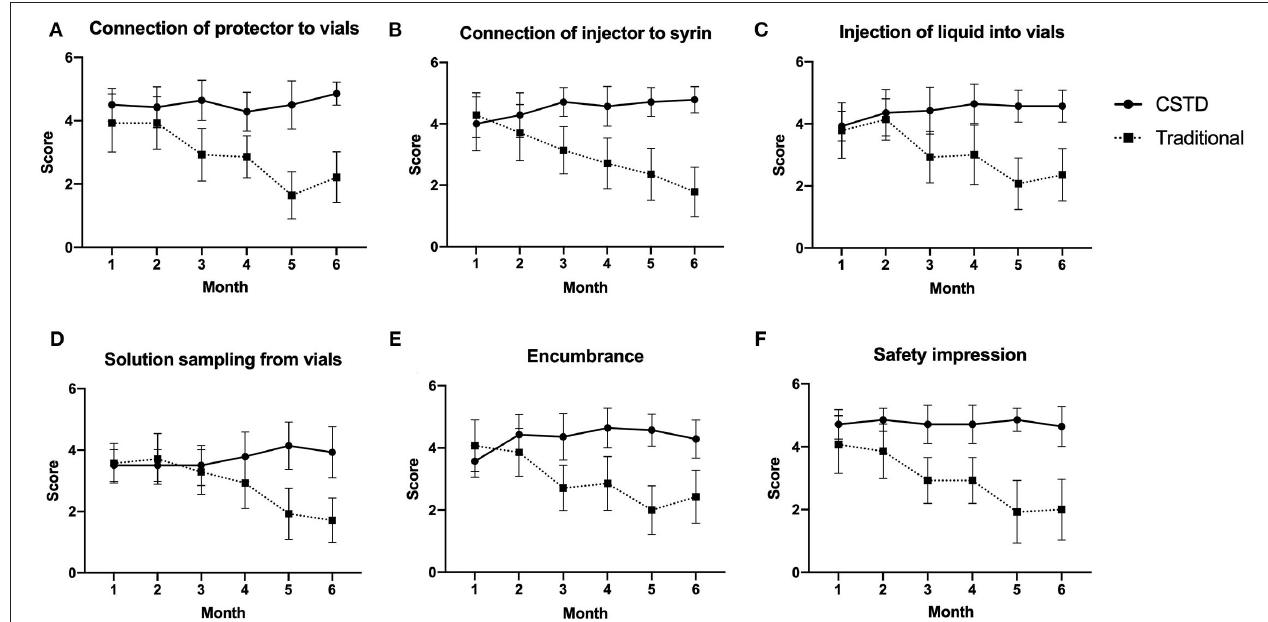
FIGURE 5 | The satisfaction comparison of ergonomics, encumbrance, and safety impression. (A) Connection of protector to vials, (B) connection of injector to syrin, (C) injection of liquid into vials, (D) solution sampling from vials, (E) encumbrance, (F) safety